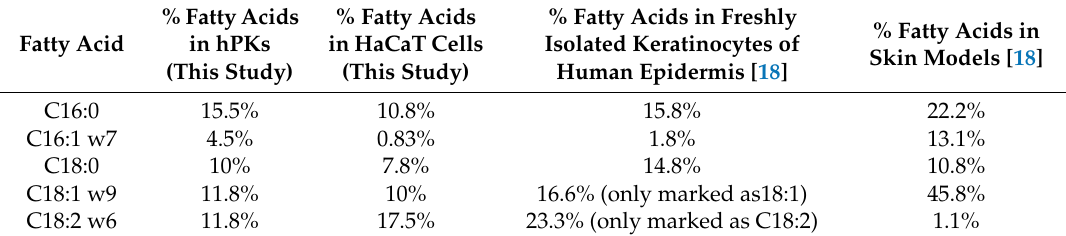
Table 1. The composition of fatty acids isolated from hPKs or the keratinocyte cell line HaCaT, as well as from isolated human epidermis keratinocytes and skin models is indicated as percentage. Own GC-FID data were compared with the data from the literature.